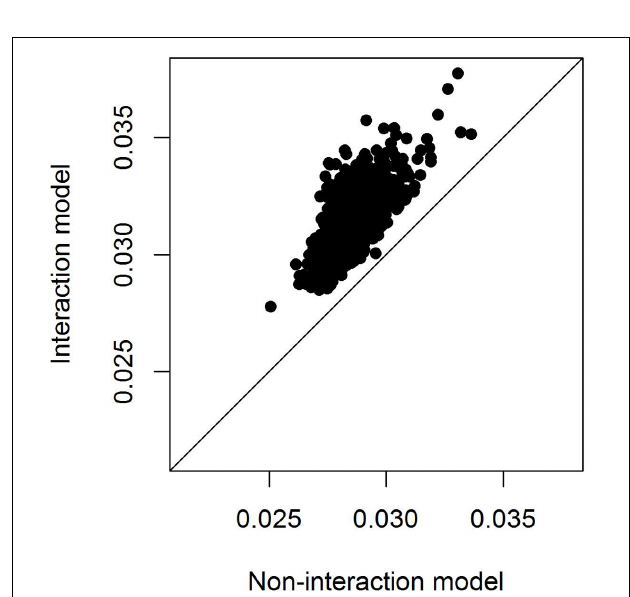
FIGURE 4 | Adjusted marginal r 2 of models with and without SNP ∗ temperature interaction. The marginal r 2 measures the variation explained by fixed effects only and is hence appropriate here because the random effects structure of the models is identical. The r 2 is only plotted for models in which either the SNP effect or the interaction SNP ∗ temperature was significant at the 0.05